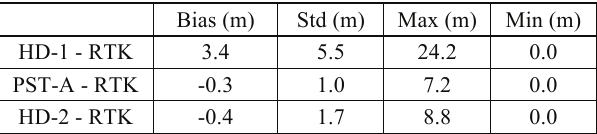
Table 6: Statistics of the modulus of the differences between HD-1, PST-A and HD-2 DTMs and